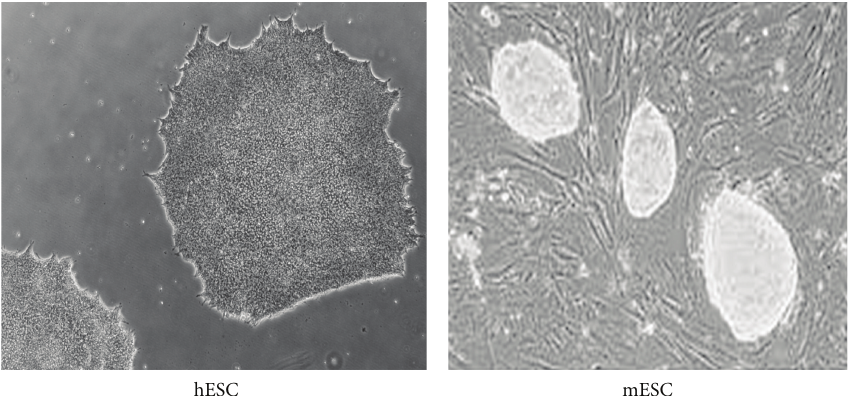
Figure 2: Morphology of hESCs and